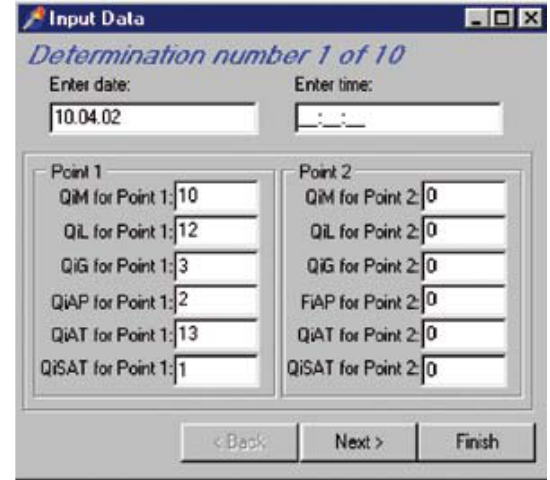
fig. 4. Interactive window for the input of traffic volume